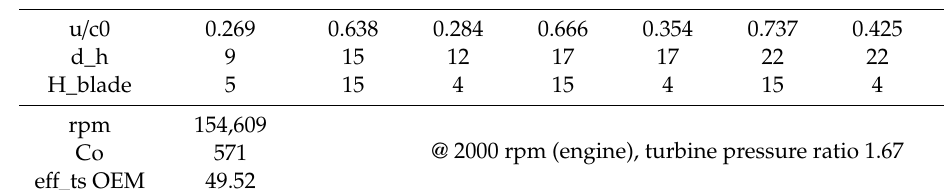
Figure 14. Left: Highly distorted basic mesh with many elements with det(J) ratio ≤ 0 (red elements). Right: Corrected high-quality mesh with the same geometry, ensuring stable and accurate CFD calculations.